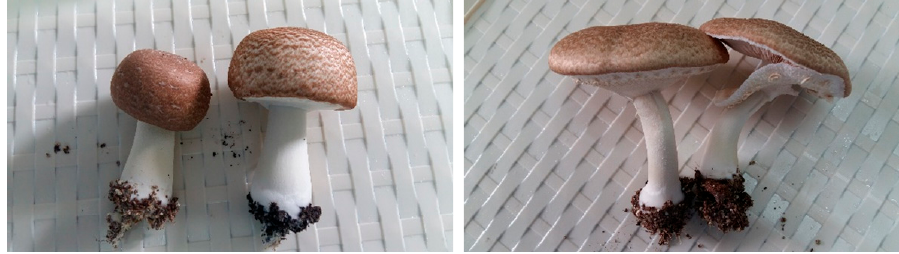
Figure 9. Agaricus blazei Murrill mushrooms hat. Source: Photo original—SC CIUPERC Ă RIA SRL, Aghiresu-Fabrici, Cluj County.